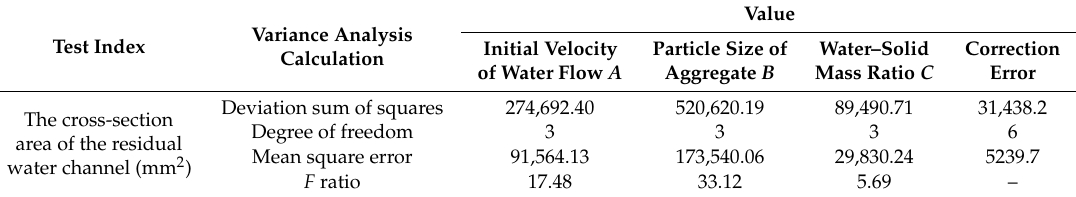
Table 4. Analysis of variance of cross-sectional area of residual water